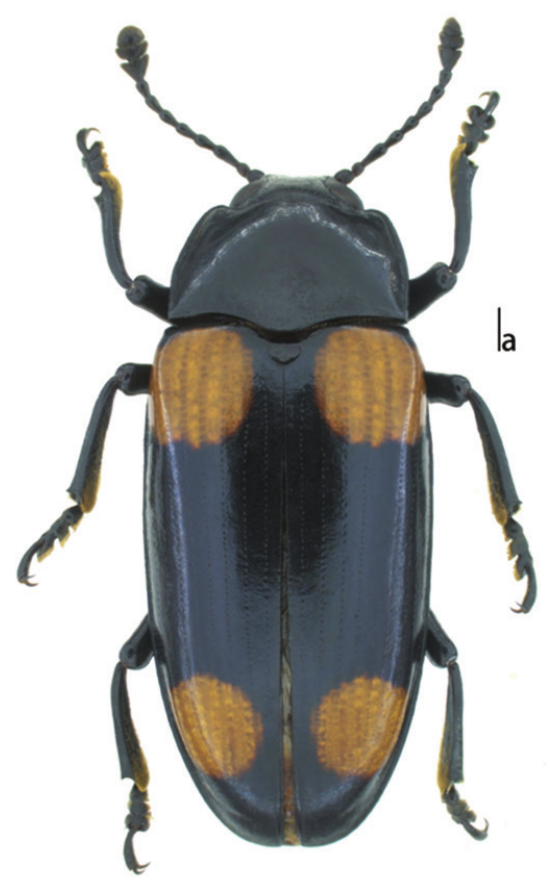
Figure 1. Habitus of Micrencaustes ( Mimencaustes ) rotundimaculata sp. n. Scale bar 1.0 mm.